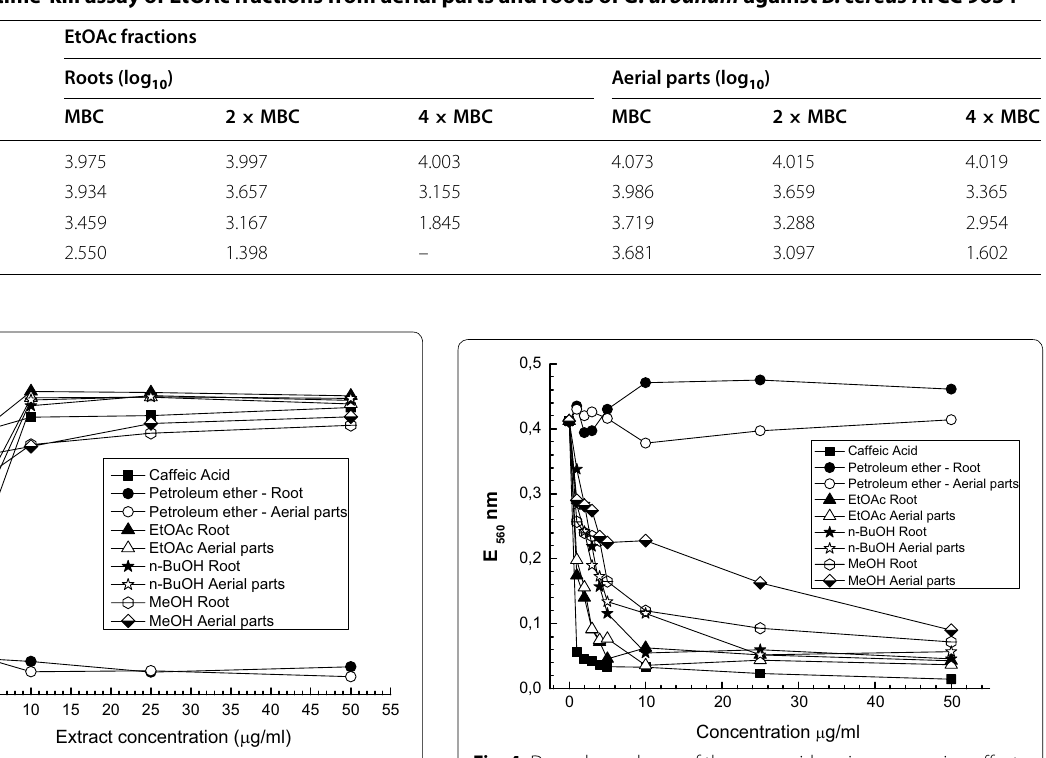
Fig. 2 Free radical scavenging effect of different MeOH extracts and fractions from G. urbanum (DPPH• assay)